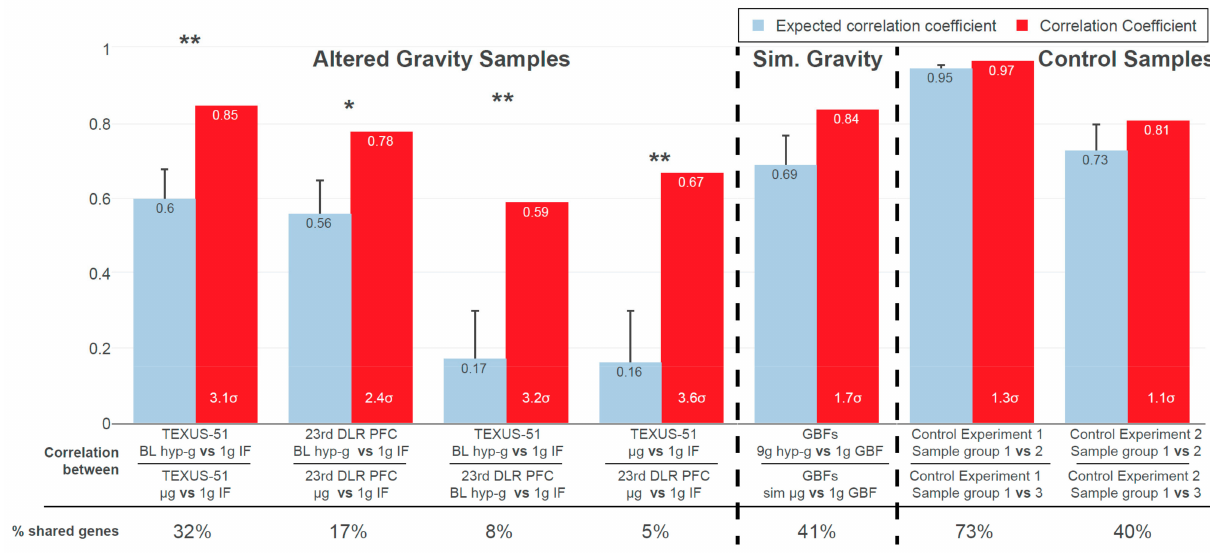
Figure 3. Results from gravity-responsive chromosomal region (GRCR) analysis: average expected correlation coefficient and first standard deviation (blue, error bars) vs. actual Spearman correlation coefficient (red) of selected comparisons. Results are grouped into those where the transcriptional effects emerged from different gravity conditions and those that did not. The relative difference is indicated in standard deviations at the bottom of the columns. Significantly different samples with inter-experiment correlation coefficients of >2 σ are indicated with *, and highly significantly different samples with inter-experiment correlation coefficients of >3 σ are indicated with **. The larger the relative and absolute difference in correlation strength between the expected and the actual dataset, the more a comparison deviates from the average distribution differential gene expression. Below, the percentage of genes that are shared between the two compared differential expression sets out of all genes that contribute to the averaging bins are listed. The strongest absolute and relative difference in correlation can be observed for inter-experiment comparisons for altered gravity contrasts, which also share the smallest number of